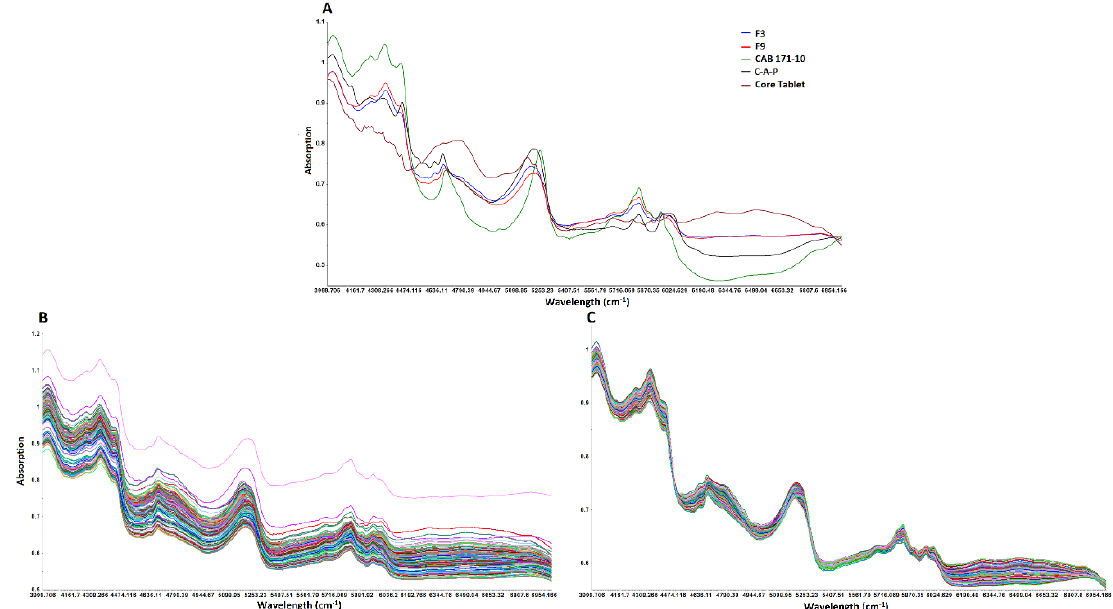
Figure 7. NIR spectra of ( A ) core, coating components, and coated tablets, ( B ) raw and ( C ) multiplicative scattered corrected.